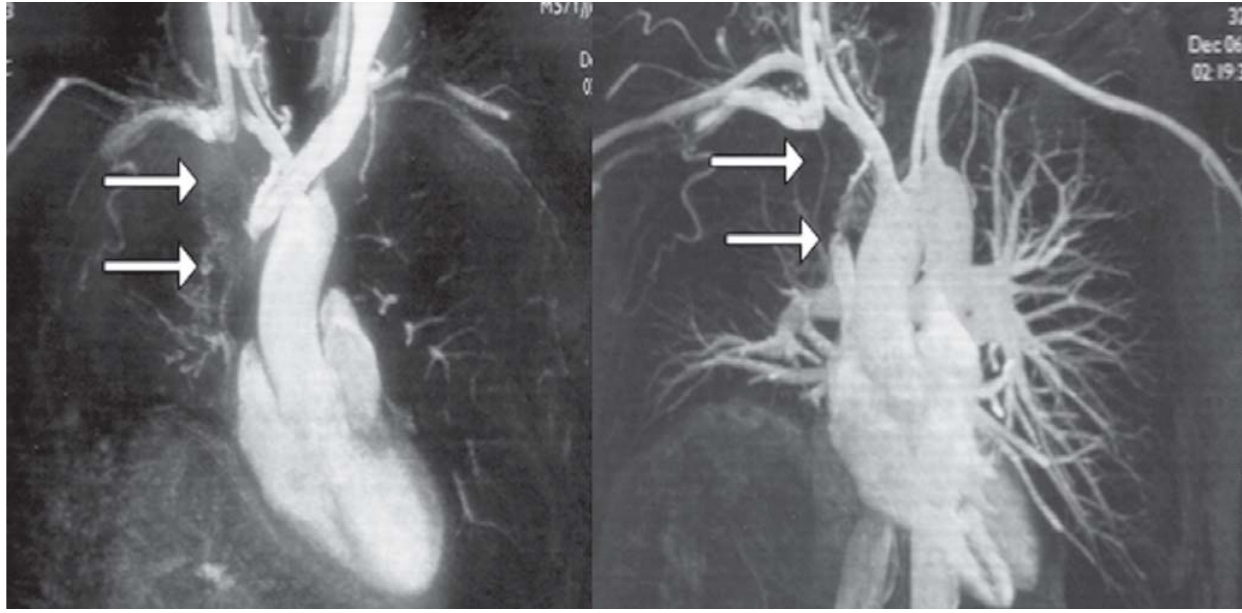
Fig. 1 - Imagens da angioressonância venosa e arterial dos vasos torácicos. As setas indicam a oclusão da veia cava superior e inominada direita causada por uma massa discretamente heterogênea localizada na região do mediastino médio e